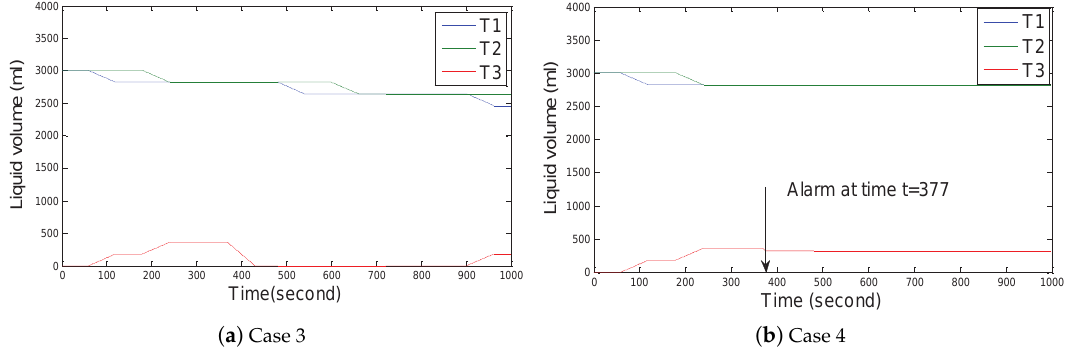
Figure 9. The real values of sensors under false sequence < V 11 o , V 11 f >